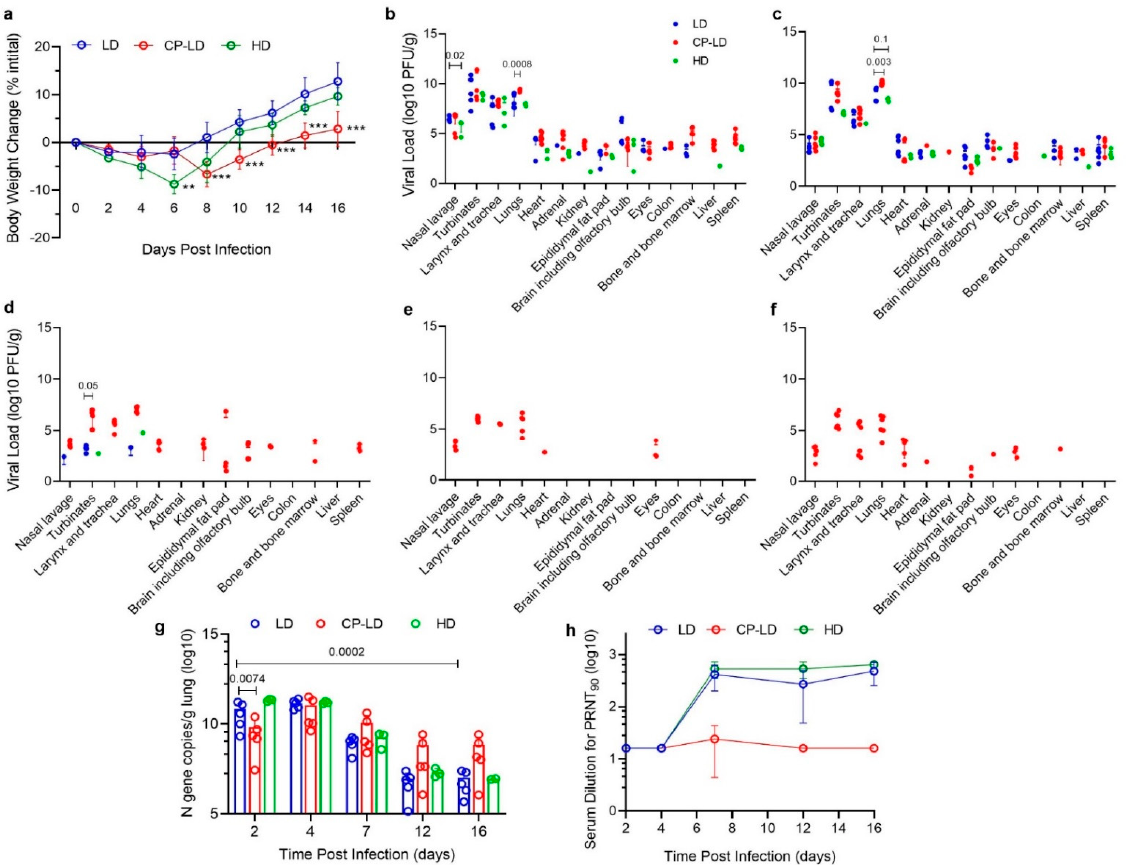
Figure 1. COVID-19 disease in SARS-CoV-2-infected hamsters. Comparison of body weight change ( a ) in LD (10 2.5 PFU, n = 30), HD (10 5 PFU, n = 15), and CP-LD (immunocompromised; 10 2.5 PFU, n = 30) SARS-CoV-2-infected hamsters over 2–16 dpi. Median weight change (g) over 2–16 dpi, compared to weight at the time of infection. Comparison of viral load ( b – f ) in SARS-CoV-2-infected hamsters (LD vs. HD, and LD vs. CP-LD) at 2–16 dpi, expressed as PFU/g of tissues. The expression of SARS-CoV-2 N gene copies/g of lungs over 2–16 dpi in LD, HD, and CP-LD-infected hamsters ( g ). Kinetics of plaque reduction neutralization titer in hamster sera collected at 2–16 dpi ( h ). Data represent mean ±SD. and each dot represents data from an individual hamster. LD and CP-LD; n = 4–6, HD, n = 3 per time point; only animals that showed a positive response were included in the plots. Statistical analysis was performed by one-way ANOVA with Tukey’s multiple group comparisons. ** p < 0.01; *** p < 0.005. Significant p -values in ( b – g ) are indicated above the plots. 3.2. Viral Burden in Immunocompetent Hamsters Infected with a Low or High Dose Inoculum In both LD and HD-infected hamsters, the highest viral burden was detected in the lungs, turbinate, and larynx/trachea at 2 dpi (Figure 1b). The viral load in these organs did not significantly change between 2 and 4 dpi. At this time point, infectious viral particles were also detected in the heart, adrenal gland, epididymal fat pad, brain (including olfactory bulb), and eyes of both LD and HD-infected animals (Figure 1b,c). However, at both 2 and 4 dpi, the viral load in these extrapulmonary organs was about 3–4 logs, significantly lower than in the lungs (Figure 1b,c). In the LD-infected hamsters, viruses were detected in the colon, kidney, and adrenal glands of one out of six animals at 2 and 4 dpi in the liver and spleen. In contrast, at 4 dpi, none of the hamsters had viruses in the colon and kidney, and three had viruses in the